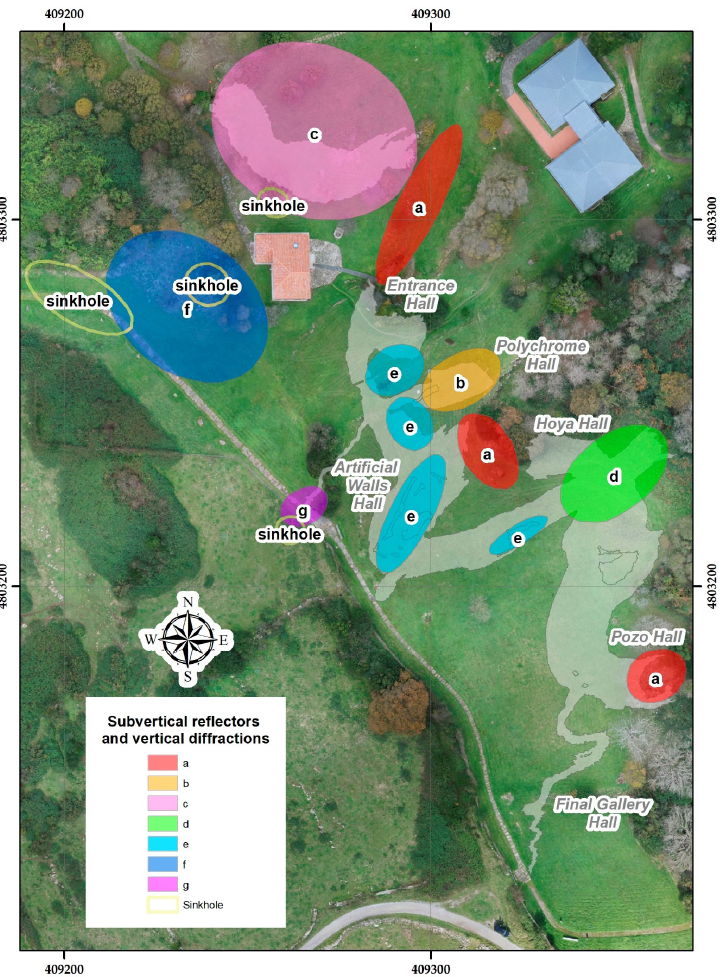
Figure 12. Zonal distribution map of subvertical reflectors and vertical diffractions (fractures) from GPR profiles in the rock massif of Altamira Cave: ( a ) the surrounding sinkholes, cave entrance, areas of Hoya Hall and Pozo Hall; ( b ) the Polychrome Hall; ( c ) the Cave of the Stalactites; ( d ) the Hoya Hall; ( e ) the artificial walls; ( f ) an area to the NW where a house and a cowshed with its dunghill were located; ( g ) the end zone of the westernmost branch line. Sinkhole areas pinpointed by GPR in the rock massif of Altamira Cave are indicated by yellow ovals.